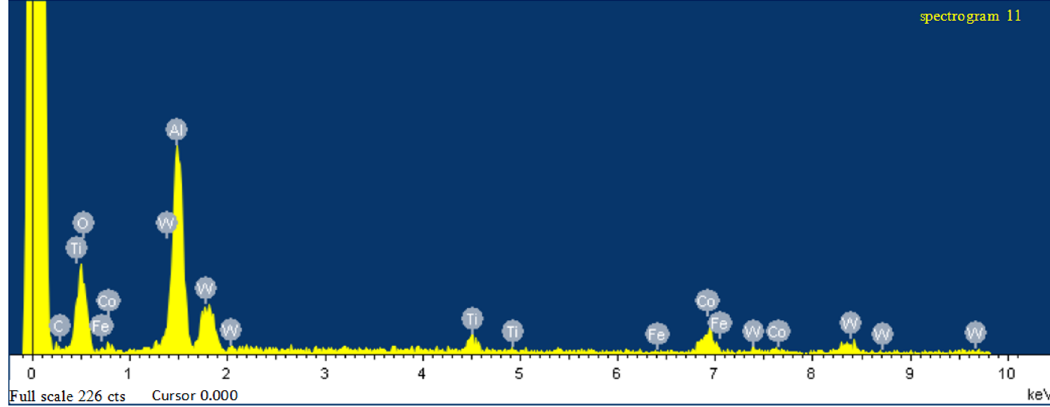
Figure 9: Energy spectrum